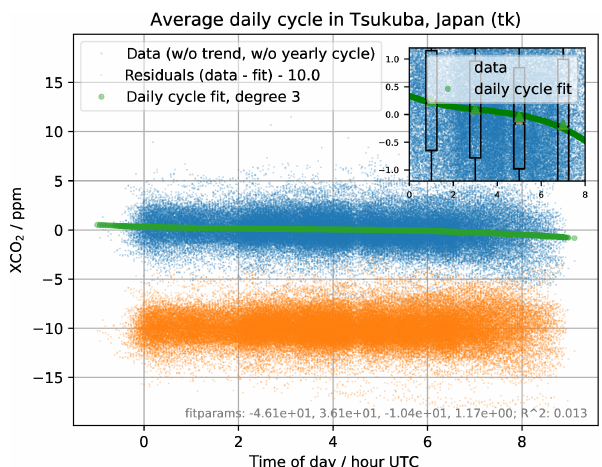
Figure 2. To remove a potential bias from correlation of wind di- rection with daytime, which would couple in the signal from photo- synthesis and respiration, the daily cycle is removed by fitting and subtracting a polynomial of degree 3. Degree 3 was chosen empiri- cally. The fit has low R 2 because the data are dominated by